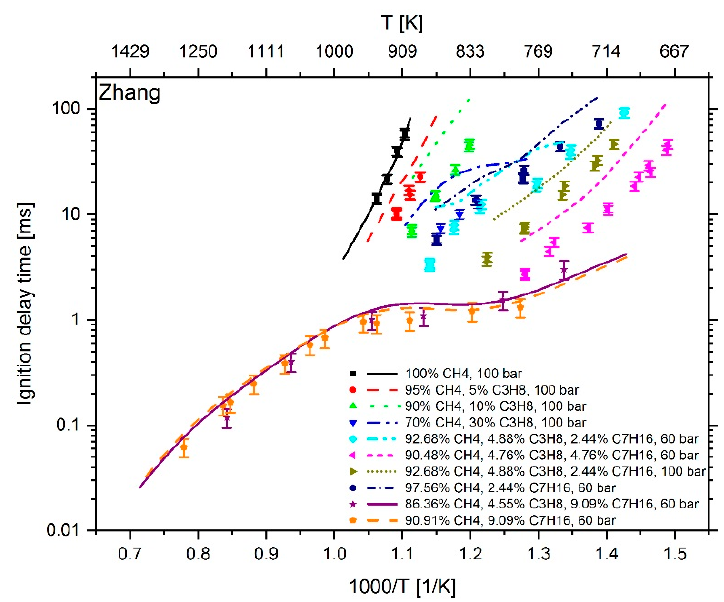
Figure 9. Experimental data (symbols) [6,7] versus model prediction (lines) using the mechanism of Zhang et al. [21].